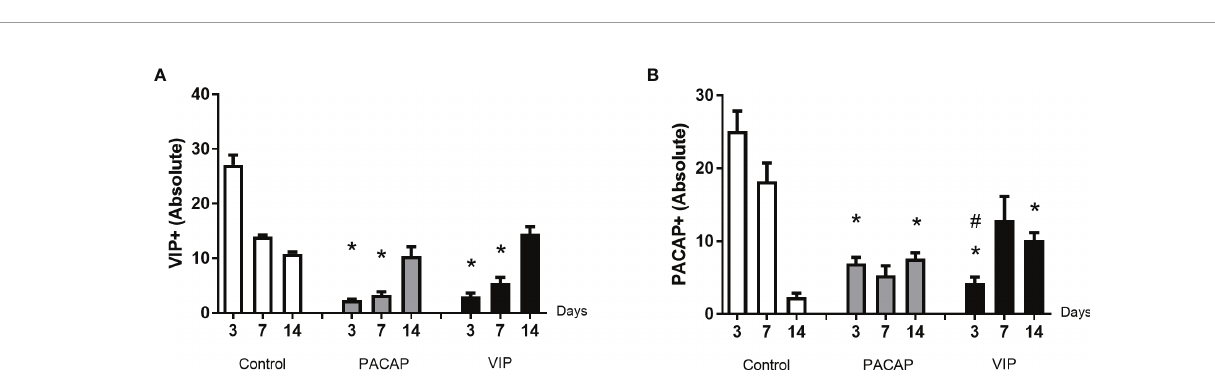
FIGURE 6 | Analysis of in fl ammatory cells in the alveolar bone healing kinetics after tooth extraction in control, VIP and PACAP treated mice. Immunohistochemistry quanti fi cation corresponding (A) VIP + and (B) PACAP + (* represents the differences between the control group; # represents the difference between VIP and PACAP group).